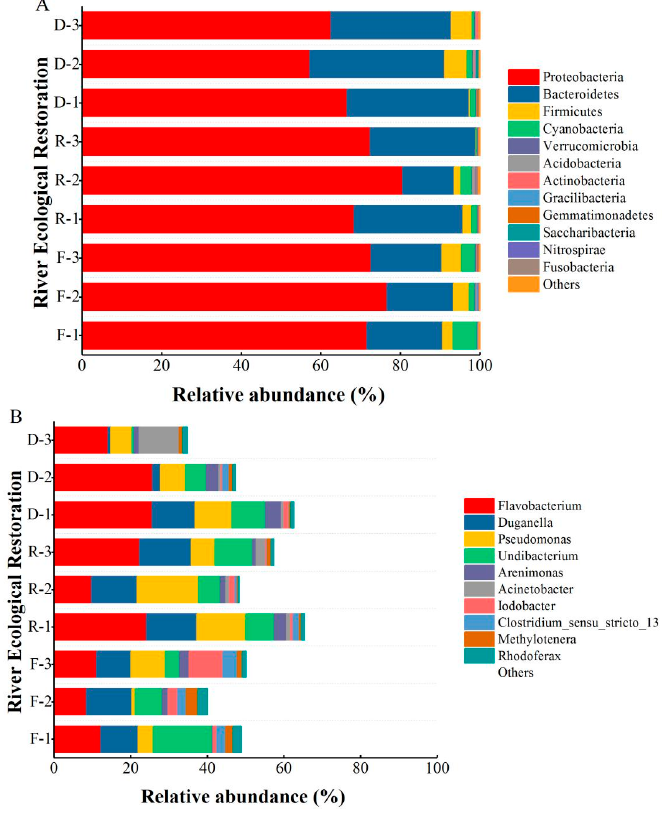
Figure 5. Relative abundance of bacterial community at Phylum ( A ) and Genus level ( B ) in forested (F), restored (R) and degraded (D) rivers within the Anji City Region.